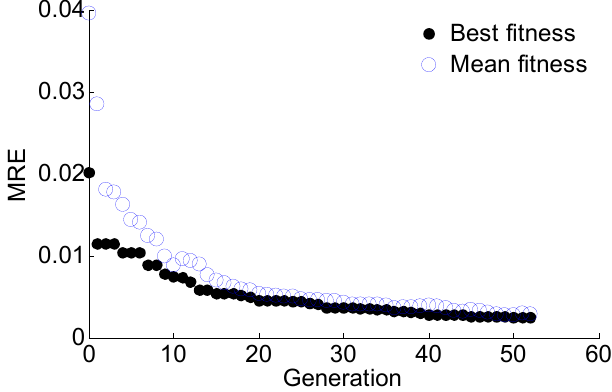
Figure 20. The optimization process using GA for model parameters.